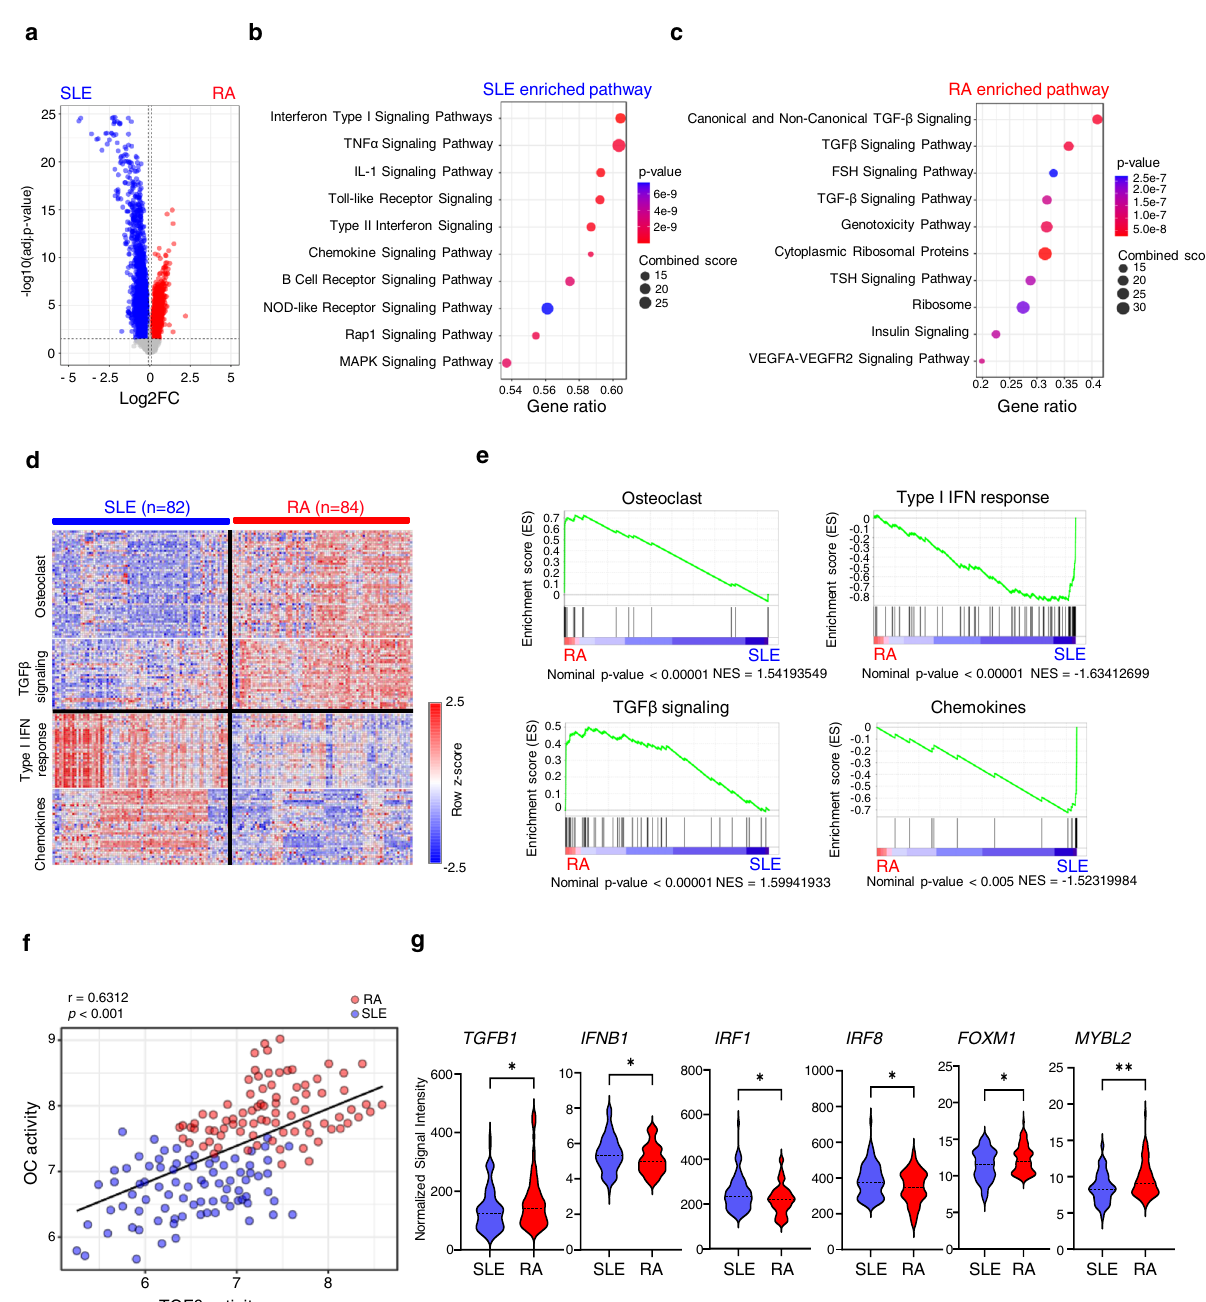
Fig. 8 Distinct TGF β level/activity contributes to different osteoclastic activity in RA and SLE patients. a Volcano plot of microarray analysis of the mRNA expression in the PBMCs isolated from SLE and RA patients. Blue dots: DEGs are more highly expressed in SLE PBMCs. Red dots: DEGs are more highly expressed in RA PBMCs. b , c Pathway analysis of the enriched DEGs in SLE ( b ) and RA ( c ). Note: c the upper TGF β signaling Pathway ID is hsa04350 and the lower TGF- β Signaling Pathway ID is WP366. d Heatmaps of mRNA expression of the genes involved in osteoclasts, TGF β signaling, Type-I IFN response, and Chemokine genes in the SLE and RA PBMCs. Row z-scores of Normalized Signal Intensity were shown in the heatmaps. n = 82 for SLE patients and n = 84 for RA patients. e Gene set enrichment analysis of DEG set (osteoclast, TGF β signaling, type-I IFN response, and chemokine) in SLE and RA PBMCs. f Scatter plot showing the signi fi cantly positive correlation between the osteoclast activity and TGF β activity. g Normalized Signal Intensity of TGFB1, IFNB1, IRF1, IRF8, FOXM1, and MYBL2 in SLE and RA PBMCs obtained from microarray data. n = 82 for SLE patients and n = 84 for RA patients. g * p < 0.05, ** p < 0.01 by Welch ’ s t test (two-sided). Source data are provided as a Source Data fi